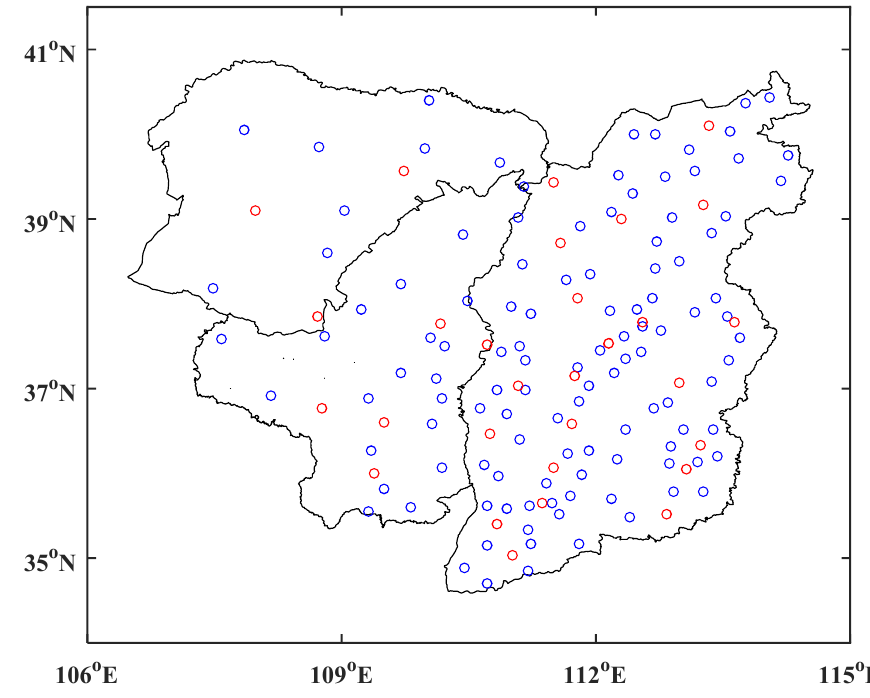
Figure 1. The research area and the distribution of the weather stations (the blue and red circles represent, respectively, the training and testing stations in one of the experiments).